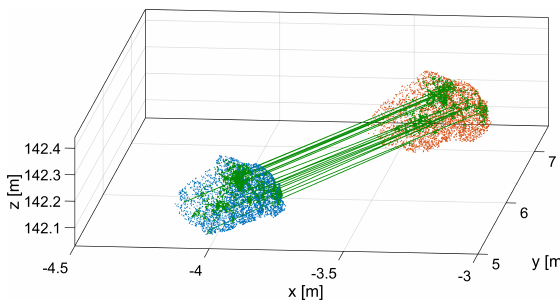
Figure 6. Results of the RB3D experiment for displaced rock : second epoch (orange), third epoch (blue). Green color denotes the points that were correctly matched. For clarity we only show 20 derived 3D displacement vectors.